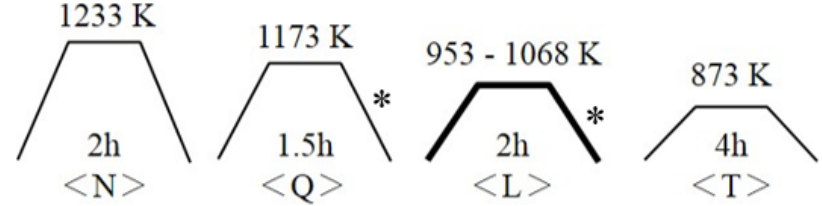
Figure 1. Heat treatment condition producing Q–L–T samples. Q: quenching; L: lamellarizing; T: temperature.